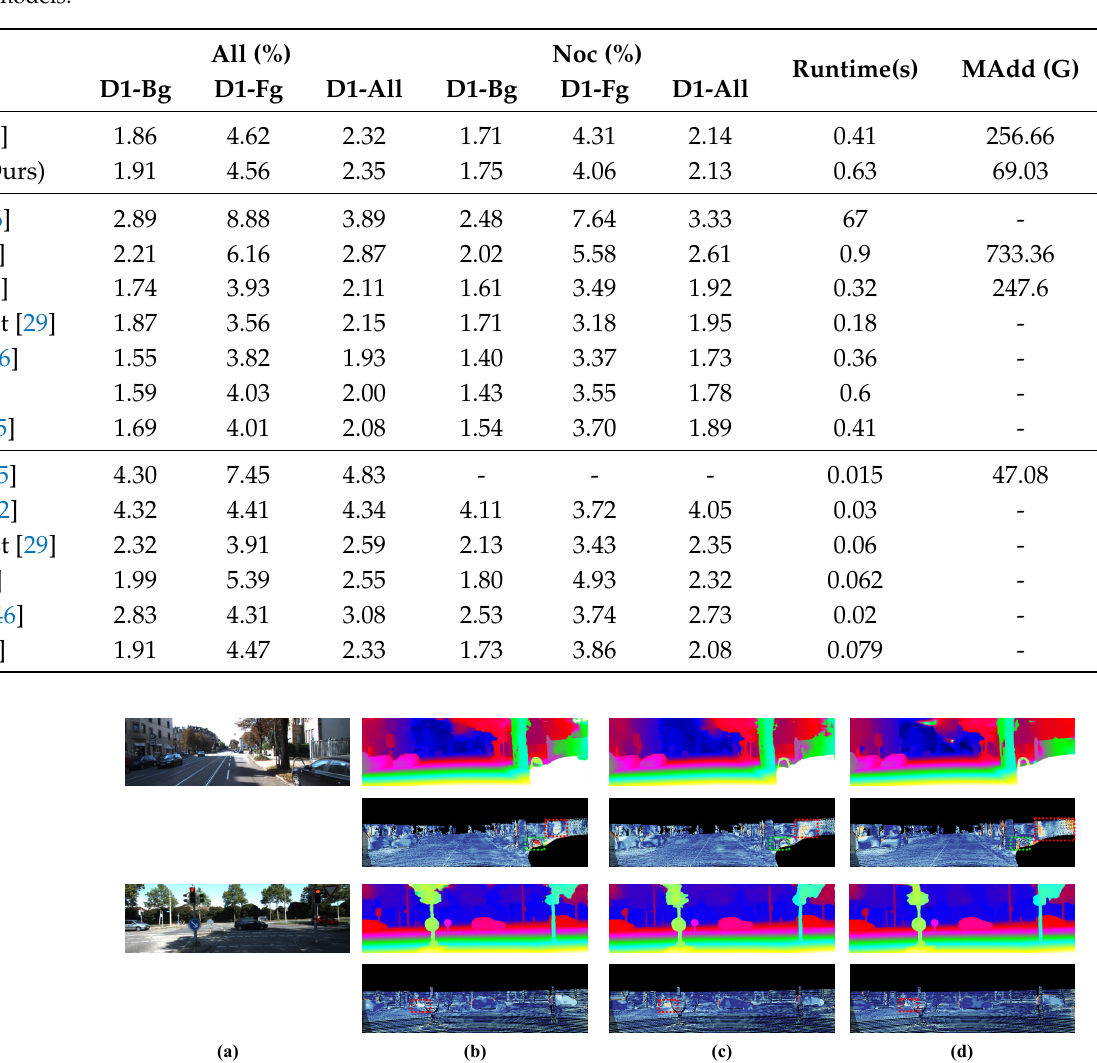
Figure 7. Visualization of prediction error on KITTI test set (red and yellow pixels denote error disparities). The red boxes denote foreground regions and green boxes denote background